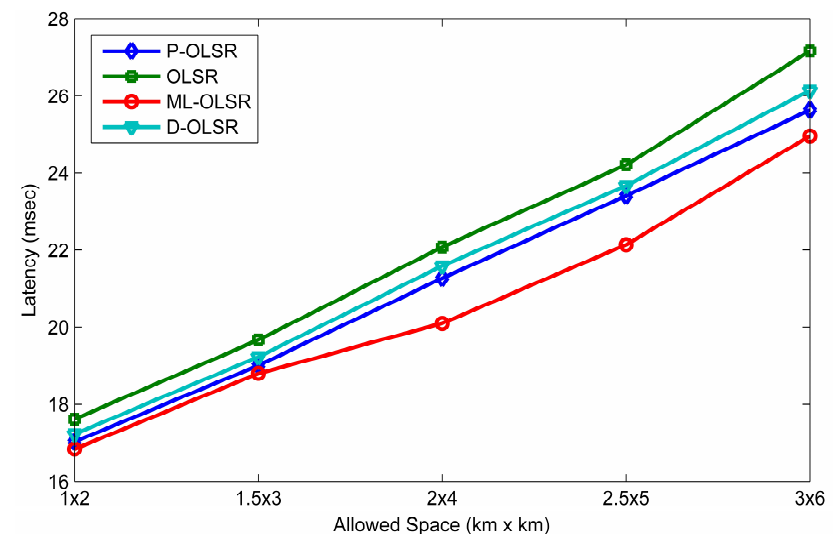
Figure 15. Latency vs. allowed space.